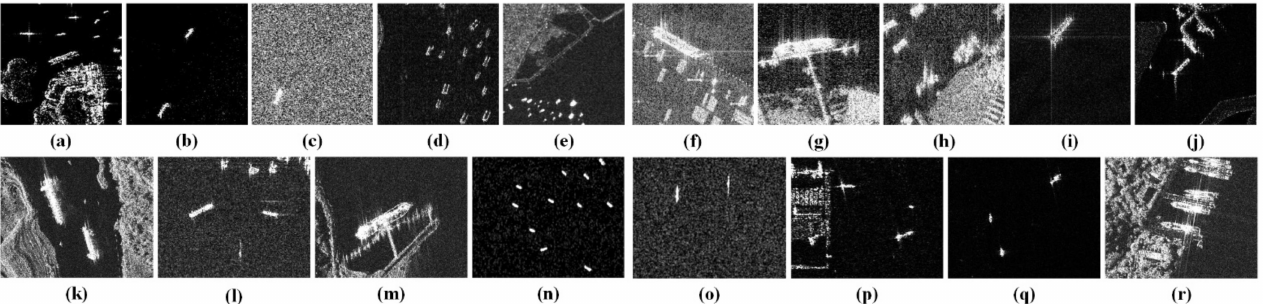
Figure 7. Some samples from two datasets. ( a – j ) The top row shows some samples from SAR-Ship-Dataset. ( k – r ) The bottom row presents some samples from SSDD. Both datasets contain a variety of complex scenarios, such as ports, inshore waters, and